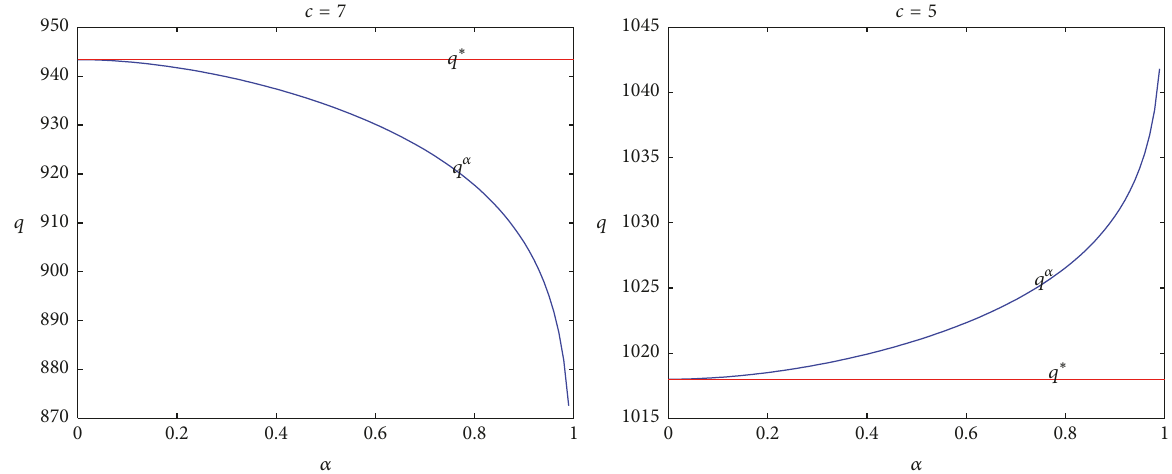
Figure 1: Optimal order quantity 𝑞 𝛼 for 𝑐 = 7 and 𝑐 = 5 when market demand follows the normal distribution 𝑁(1000, 100 2 ) .